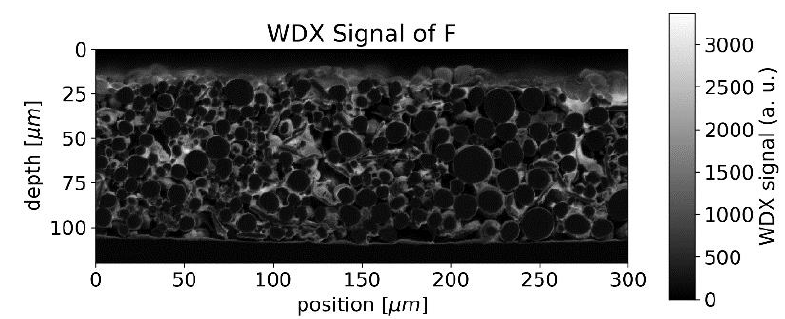
Figure 5. WDX signal of fluorine from EMPA measurement (indicating binder).